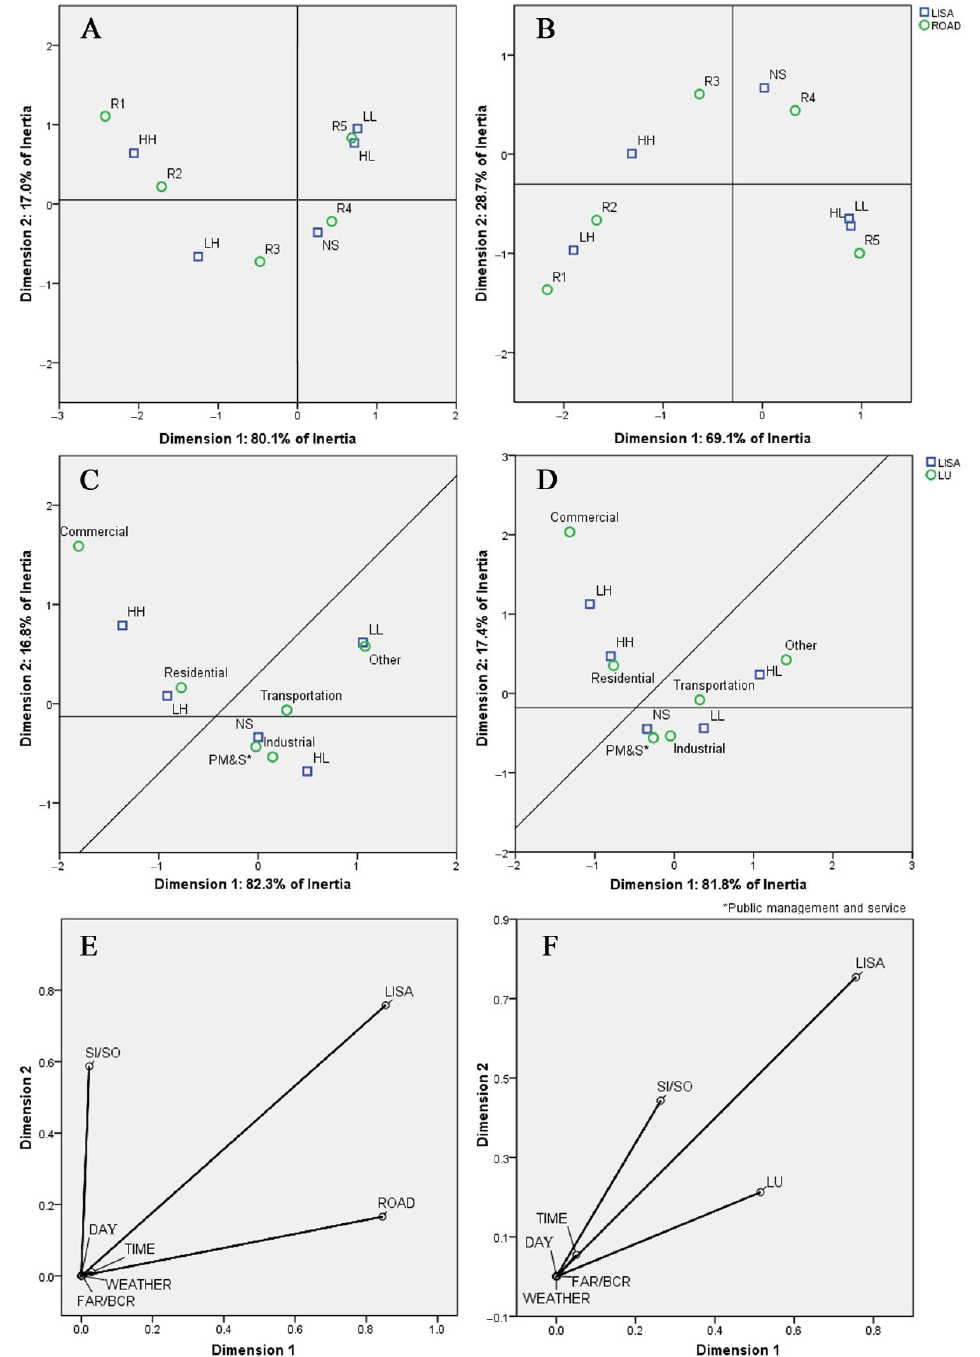
Figure 7. ( A ) Correspondence analysis between sink LISA results and different ring road regions, ( B ) correspondence analysis between source LISA results and different ring road regions, ( C ) correspondence analysis between sink LISA results and land use types, ( D ) correspondence analysis between source LISA results and land use types, ( E ) multiple correspondence analysis of different ring road regions, and ( F ) multiple correspondence analysis of land use types.